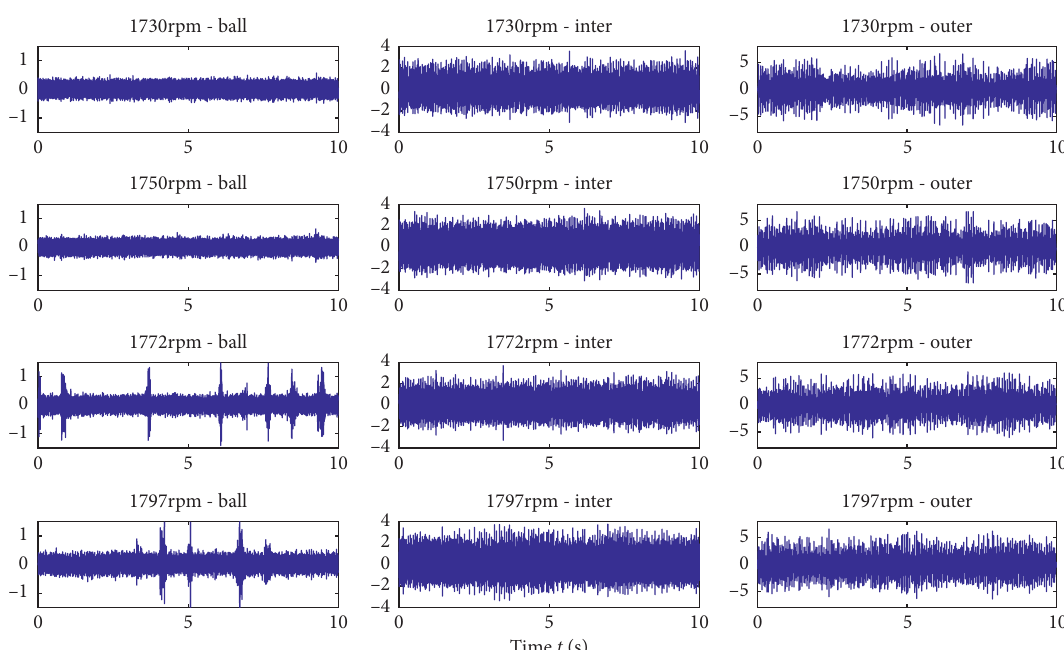
Figure 5: Bearing vibration signals in different environments.